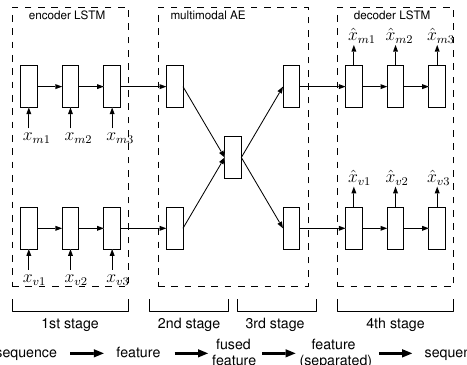
Figure 3: Multimodal LSTM